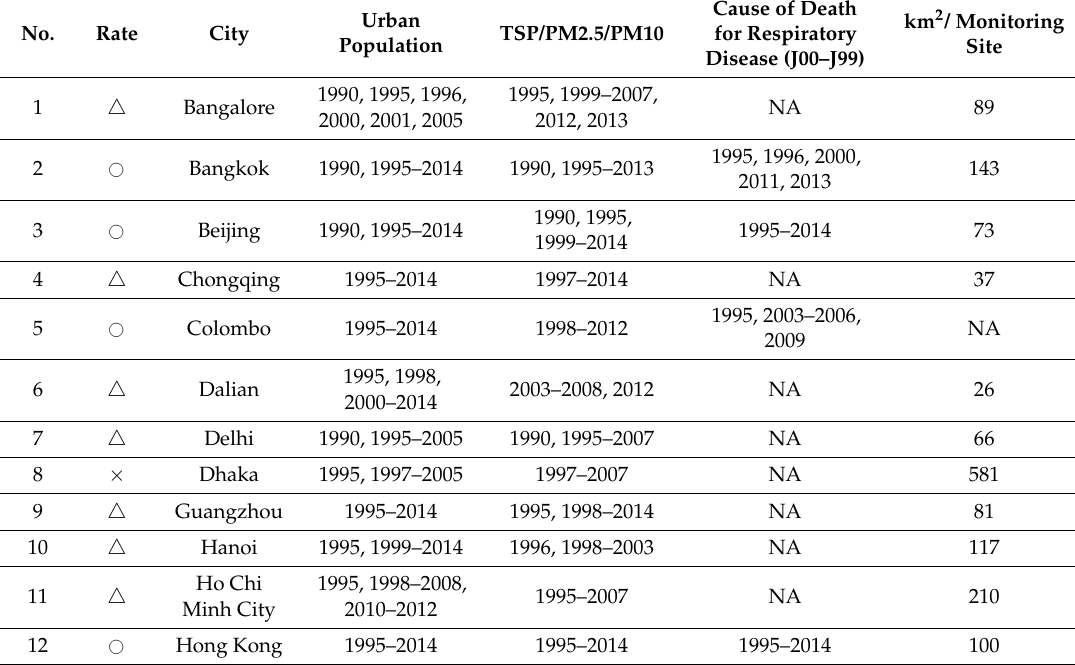
Table 1. City data availability and the surface area per monitoring site